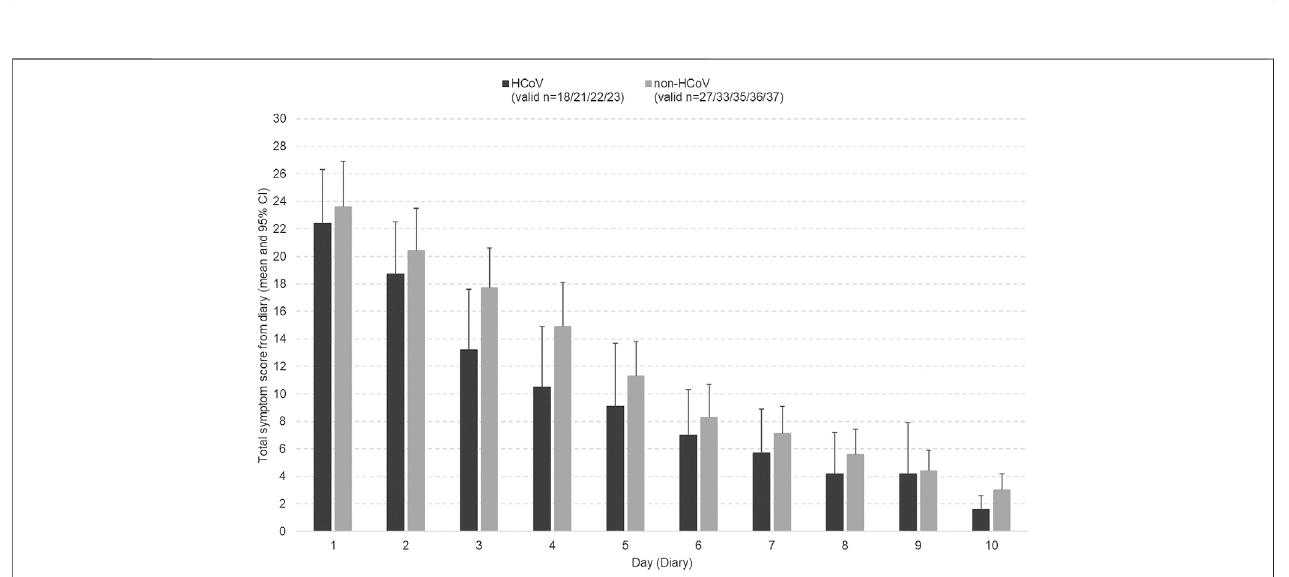
FIGURE 3 | Course of the common cold symptoms (patient diary entries) in the HCoV and non-HCoV subsets during the trial.